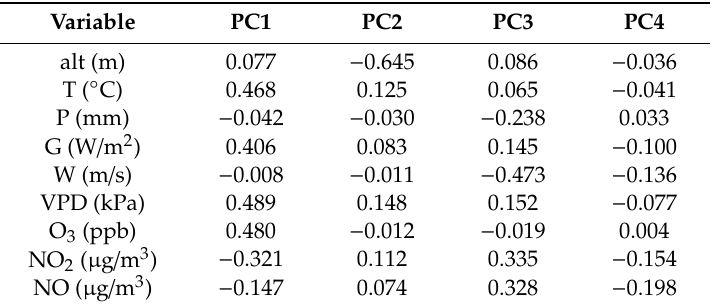
Table 4. Eigenvectors of the PCA ordination in Figure 5.